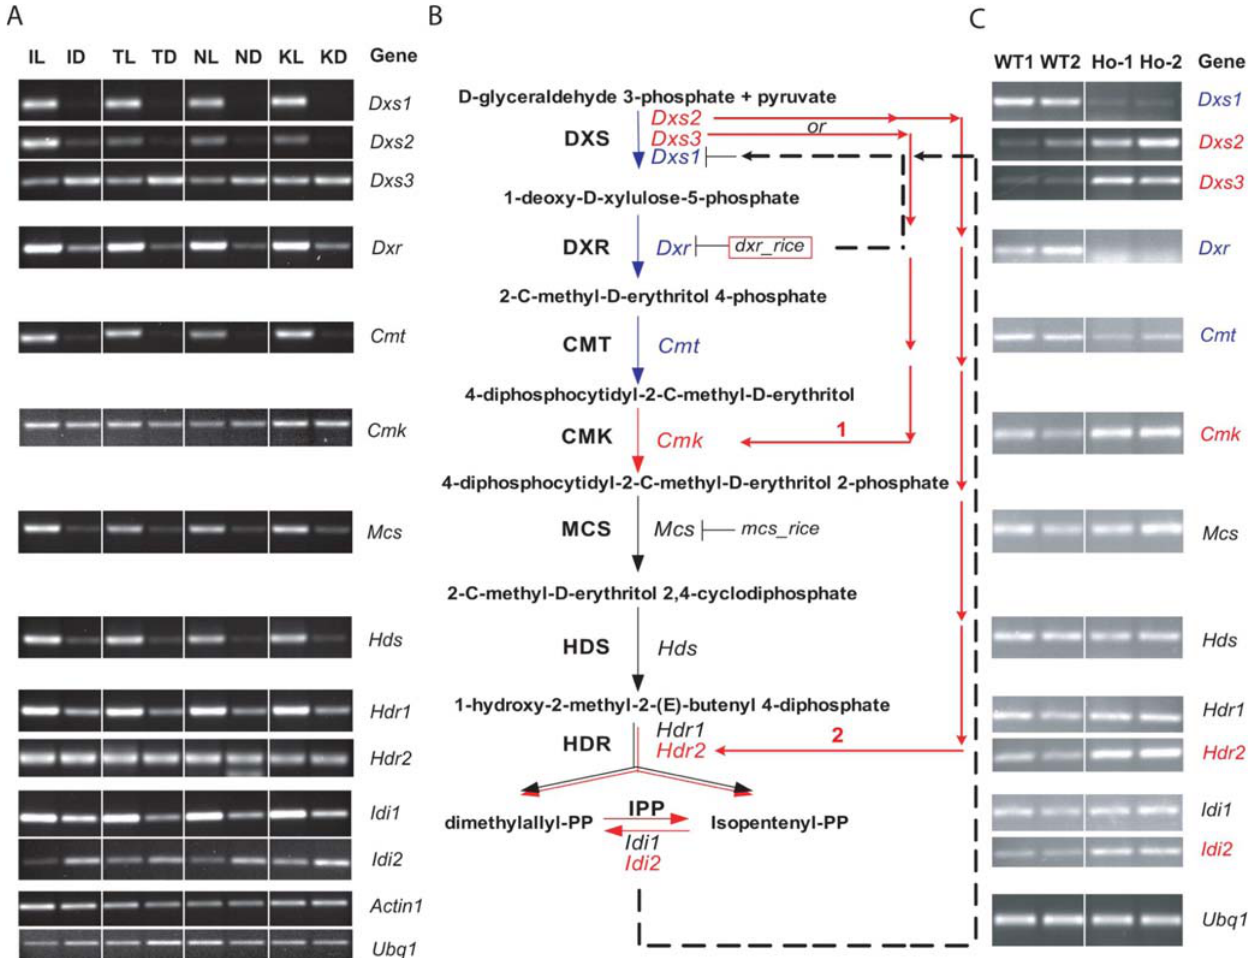
Figure 6. Altered Expression Patterns of Genes Associated with the MEP Pathway in the Rice dxr Mutant. (A) Validation of microarray data corresponding to genes in this pathway using RT-PCR amplifications. Ubq1 and Actin1 were used as controls for RT-PCR [85]. Numbers of PCR cycles are indicated. See legend for Figure 1 for explanation of column heading abbreviations. Dxs1 , Dxs2 , Dxs3: gene family members encoding 1- deoxy-D-xylulose-5-phosphatesynthase; Dxr : gene encoding 1-deoxy-D-xylulose 5-phosphate reductoisomerase (2 in B); Cmt : gene encoding 2-C- methyl-D-erythritol4-phosphate cytidylyl transferase (3 in B); Cmk : gene encoding 4-diphosphocytidyl-2-C-methyl-D-erythritol kinase (4 in B); Mcs : gene encoding 2-C-methyl-D-erythritol 2,4-cyclodiphosphate synthase (5 in B); Hds : gene encoding 4-hydroxy-3-methylbut-2-en-1-yl diphosphate synthase (6 in B); Hdr1 , Hdr2 : gene family members encoding 4-hydroxy-3-methylbut-2-enyl diphosphate reductase (7 in B) and there were two gene family members; and Idi1 , Idi2 : gene family members encoding isopentenyl-diphosphate delta-isomerase (8 in B) and there were two gene family members. (B) Proposed pathway model for explaining altered expression patterns. The MEP pathway was generated using RiceCyc (http://www. gramene.org/pathway/). Twelve candidate genes were assigned to 8 steps in the pathway. Blue colored letters and arrows indicate the suppression of gene expression in dxr mutant; black ones indicate not significantly changed gene expression patterns in dxr mutant; and red ones indicate significantly induced gene expression patterns in dxr mutant. Phenotypes in T-DNA insertional homozygous progenies in Mcs gene is displayed in Figure S8. (C) RT-PCR analysis of twelve candidate genes in this pathway in the rice dxr mutant (homozygous siblings) and its wild-type segregants. Genes indicated in red were up-regulated in the dxr mutant. Genes indicated in blue were down-regulated in the dxr mutant. Expression of genes indicated in black was not significantly changed in the dxr mutant. WT1, wild-type segregant 1; WT2, wild-type segregant 2; Ho-1, dxr homozygote 1; Ho-2, dxr homozygote 2. Ubq1 were used as controls for RT-PCR. RT-PCR amplifications were carried out as described in Material and Methods.